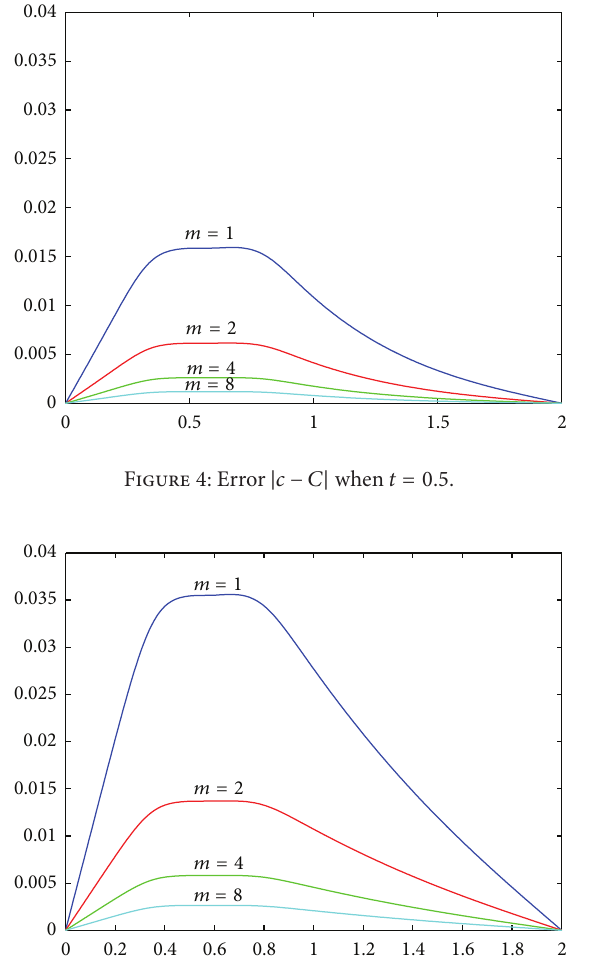
Figure 5: Error |𝑐 − 𝐶| when 𝑡 = 1